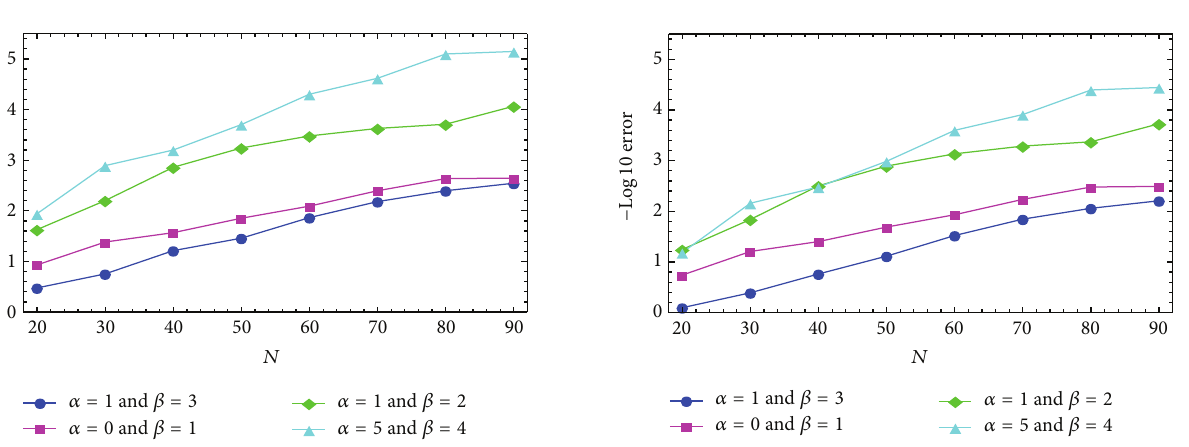
Figure 1: Maximum absolute error by using MGLT (Gauss) with the various choices of 𝑁 .